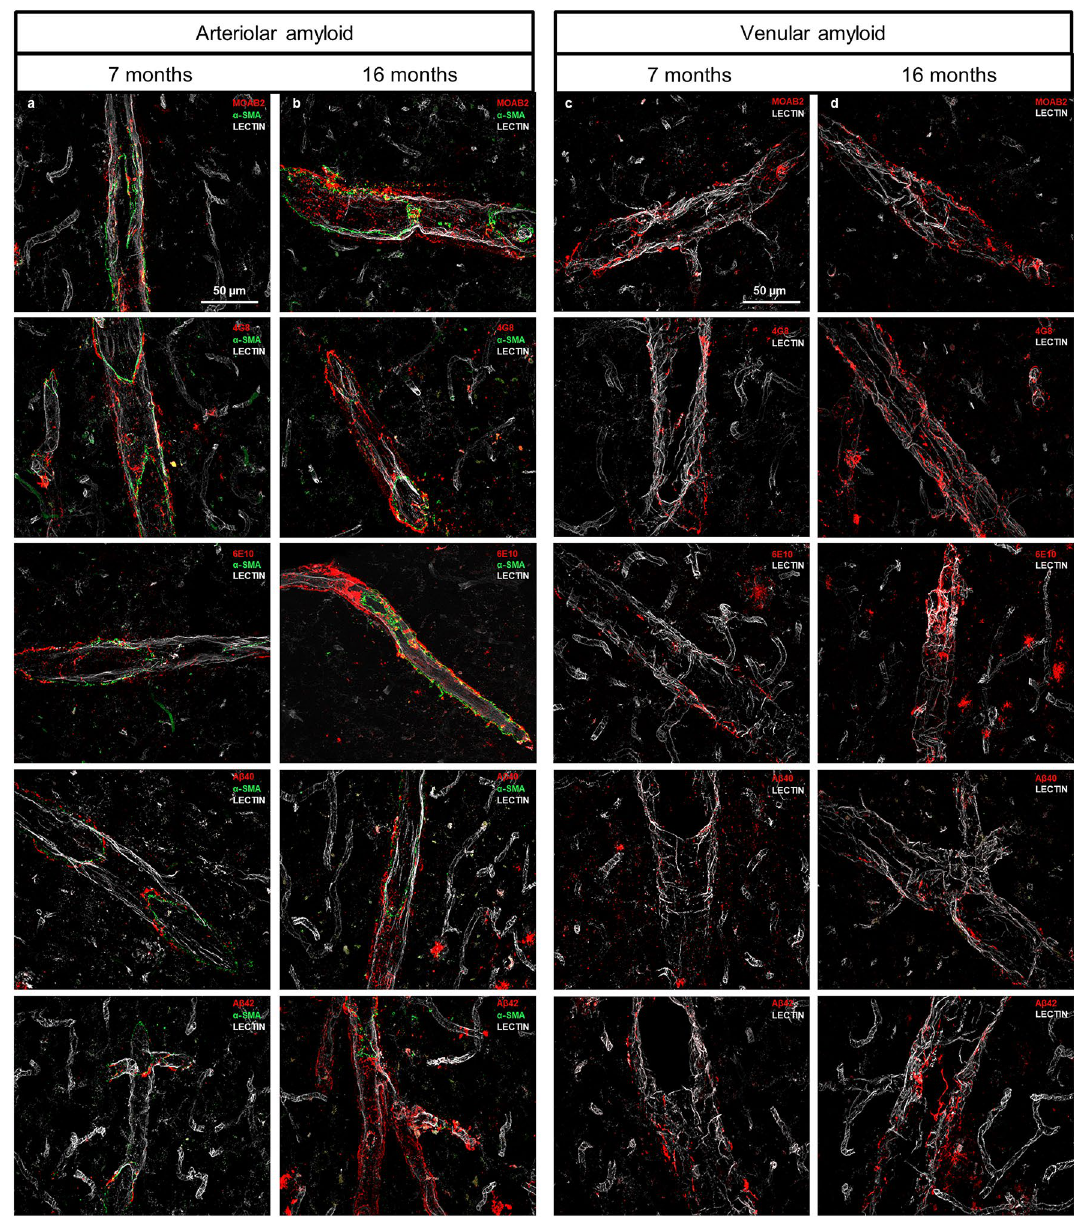
Figure 2. Arteriolar and venular amyloid stained with Aβ antibodies to visualize vascular Aβ. Aβ antibodies MOAB-2, 4G8, 6E10, Aβ 40 , and Aβ 42 (red) target specific amino acid regions of the Aβ peptide sequence, allowing for a comprehensive visualization of vascular Aβ. Arteriolar Aβ initially deposits around alpha smooth muscle actin (green), labelling the arterioles, at 7 months of age ( a ), while amyloid circles the arterioles at 16 months of age ( b ). An increase was also shown in venular Aβ, with globular deposits increasing in size and number between 7 ( c ) and 16 months of age ( d ). Images were obtained at 40 × objective.